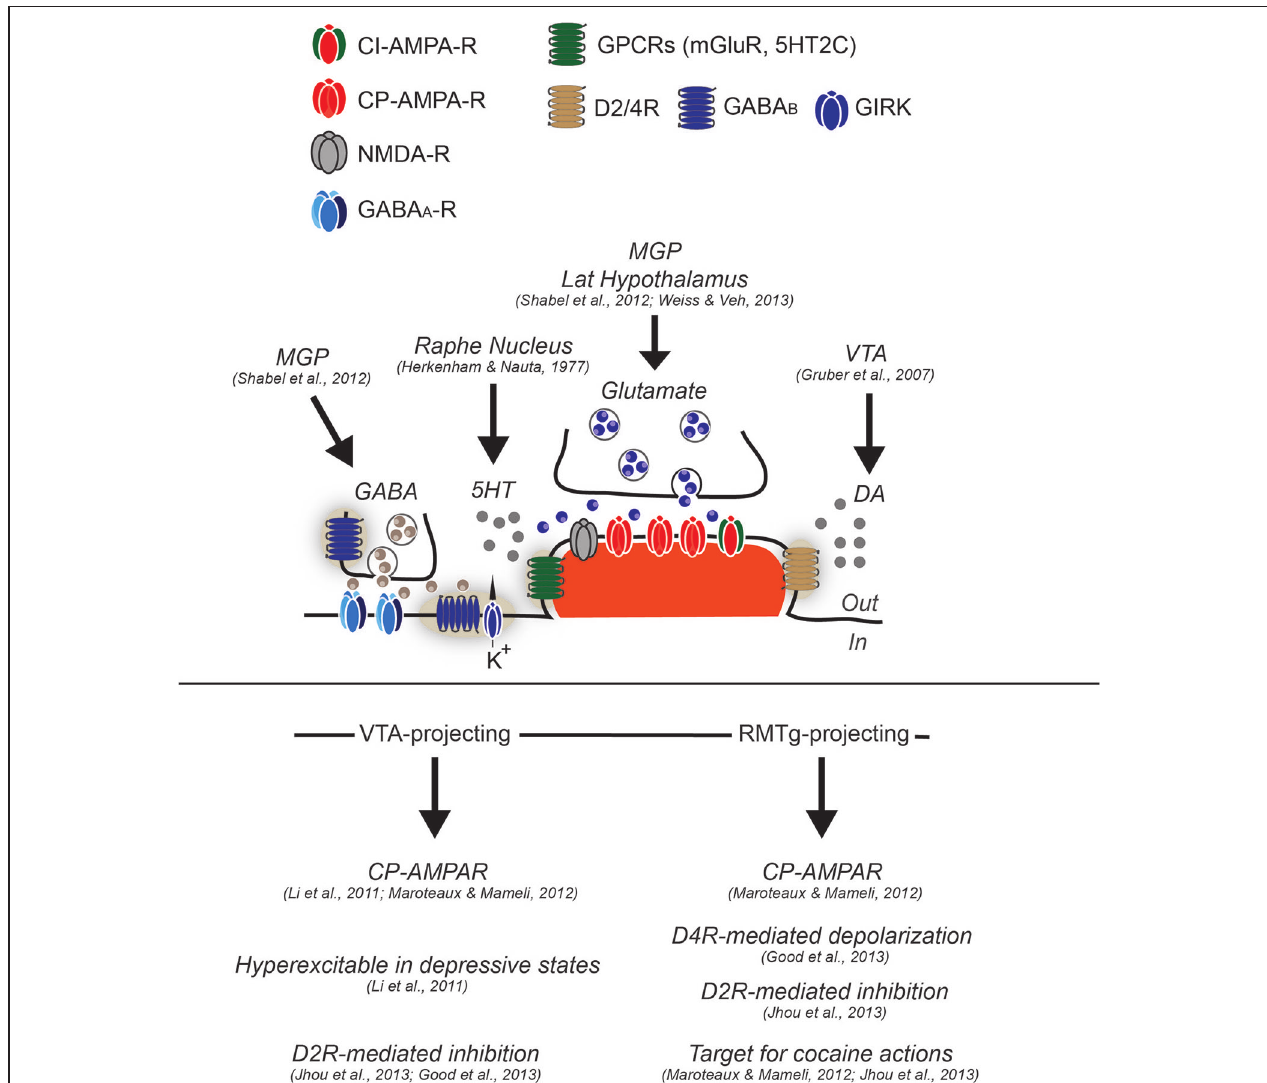
FIGURE 1 | Synaptic and cellular properties of LHb neurons. Neurons in the LHb have been generally described as glutamatergic and projection type. While some feature of excitatory synapses have been described, functional evidence regarding GABAergic transmission or other type of regulatory mechanisms remain elusive, although functional GABA inputs arise from the medial globus pallidus (MGP). Glutamate transmission (arising from MGP and lateral hypothalamus) largely relies on α -Amino-3-hydroxy-5-methyl- 4-isoxazolepropionic acid receptors (AMPA-R) lacking the subunit GluA2 and therefore calcium permeable (CP-AMPARs), although calcium-impermeable (CI-AMPARs) are likely to be expressed since the degree of inward rectification of AMPA-mediated excitatory postsynaptic currents (AMPA-EPSCs) is not complete (Li et al., 2011; Maroteaux and Mameli, 2012). The presence of mGluR have not yet been tested, however in situ hybridization images from the Allen Brain Atlas would suggest this.